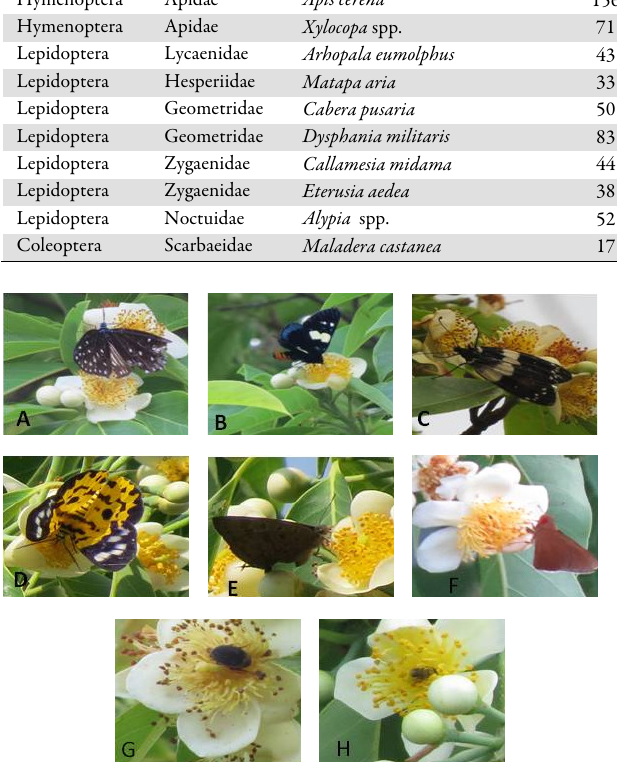
Fig.1. Different pollinators of Schima wallichii ; (A) Callamesia midama (Moth); (B) Alypia spp. (Moth); (C) Eterusia aedea (Moth); (D) Dysphania militaris (Moth); (E) Arhopala eumolphus (Butterfly); (F) Matapa aria (Butterfly); (G) Maladera castanea (Bettle); (H) Apis cerena (Indian hive bee)